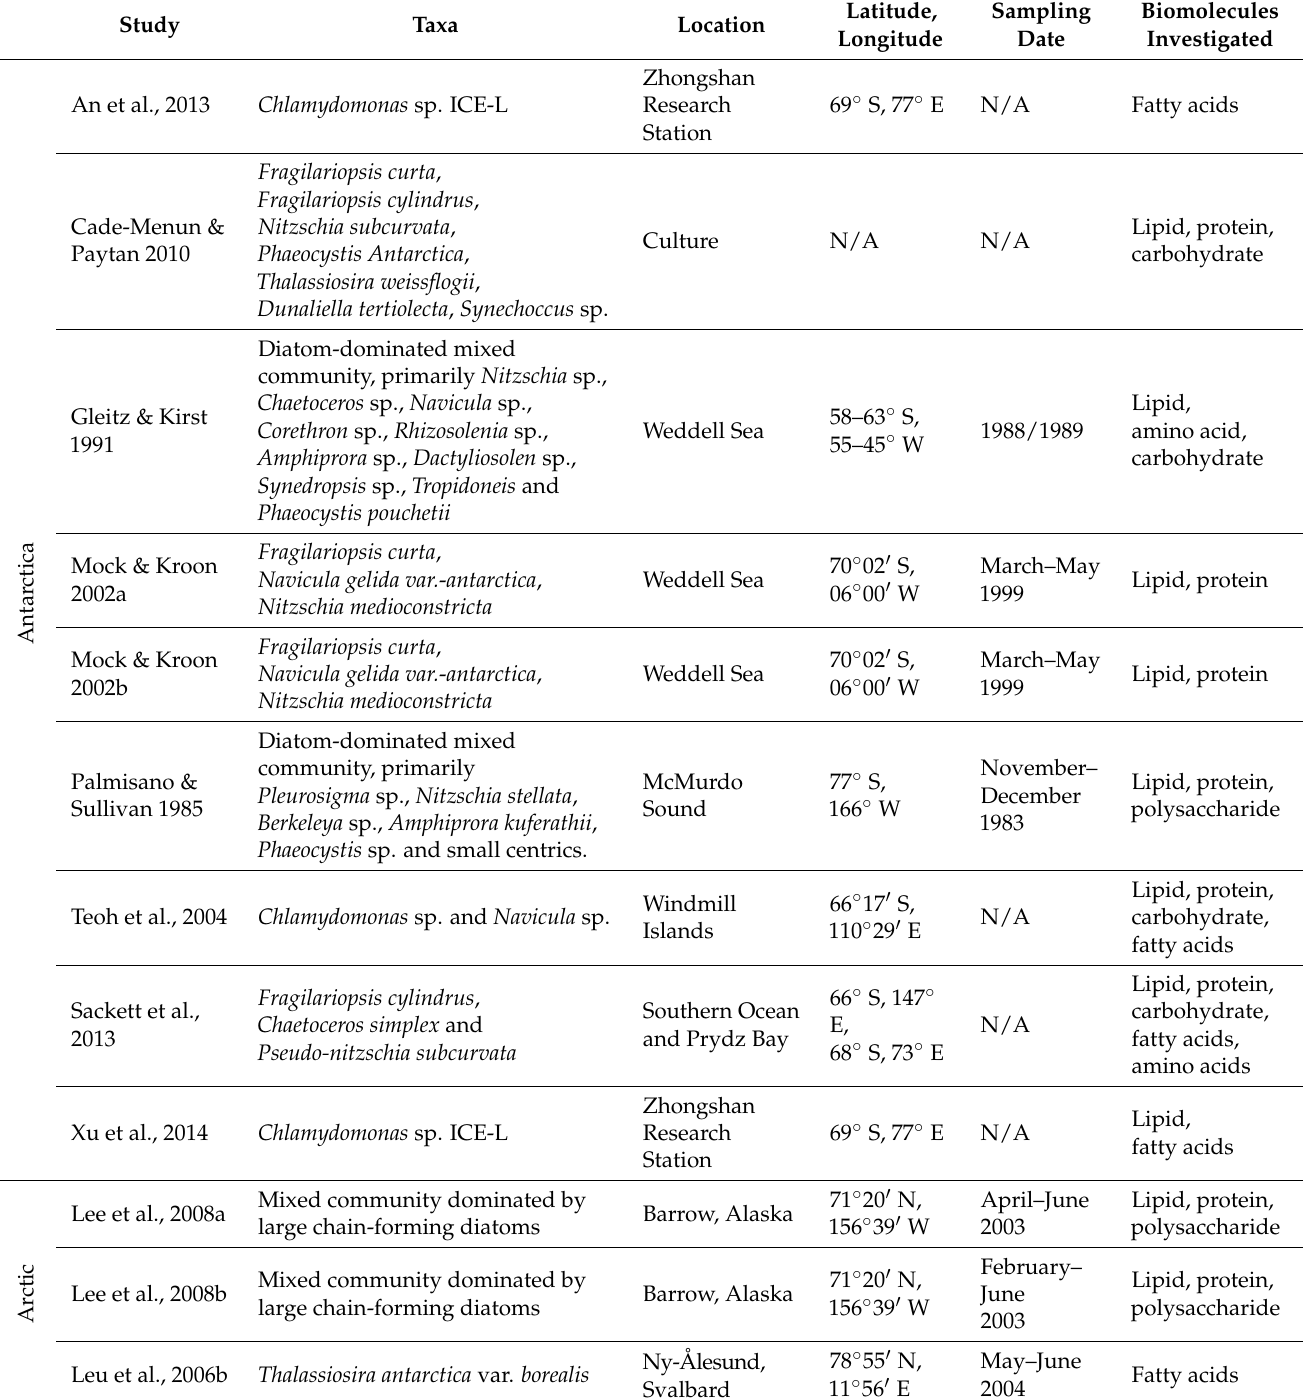
Table 1. Compilation of studies that have measured biomolecules in sea ice microalgae in the Arctic and